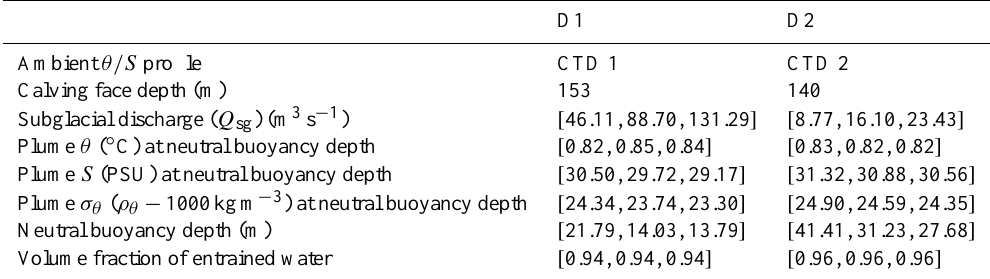
Table 4. Buoyant plume model simulations for D1 and D2 scenarios at MBM2014 subglacial discharge values. Plume θ and S ranges are plotted in Fig. 5c and